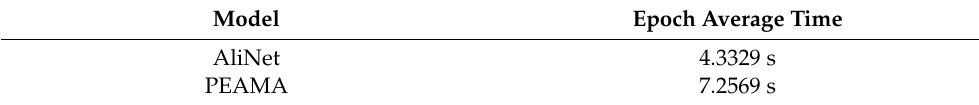
Table 5. Comparison of average training times of single